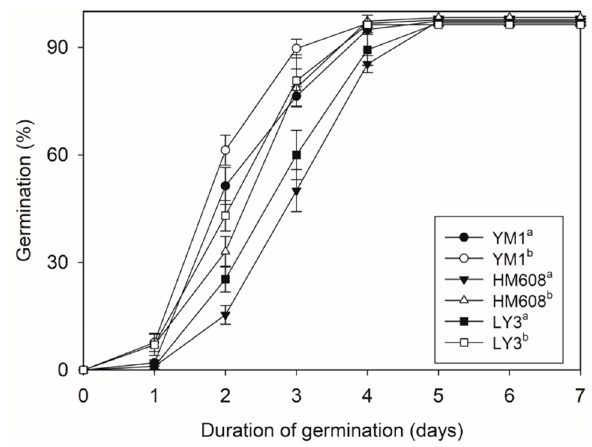
Figure 8. Effect of chloroform on wheat seed germination rates from three wheat samples (YM1, HM608 and LY3). a normal seeds (CK); b chloroform- soaked seeds (5 min). Data points are expressed as the mean ± SD of four biological replicates.